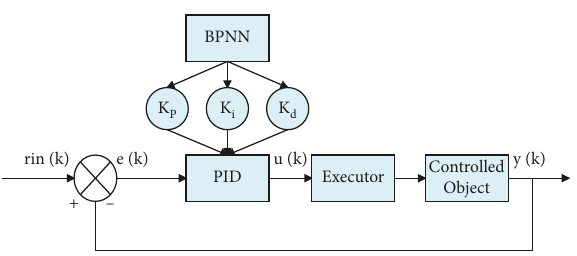
Figure 11: Control diagram of electromechanical equipment based on neural network.